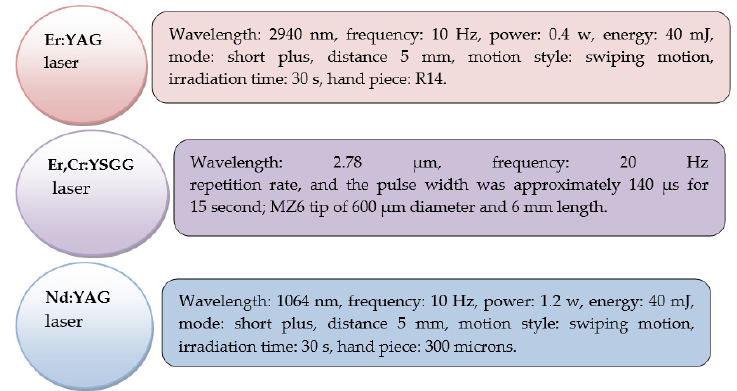
Figure 1. Parameters used for enamel etching, according to the laser type [11,15].